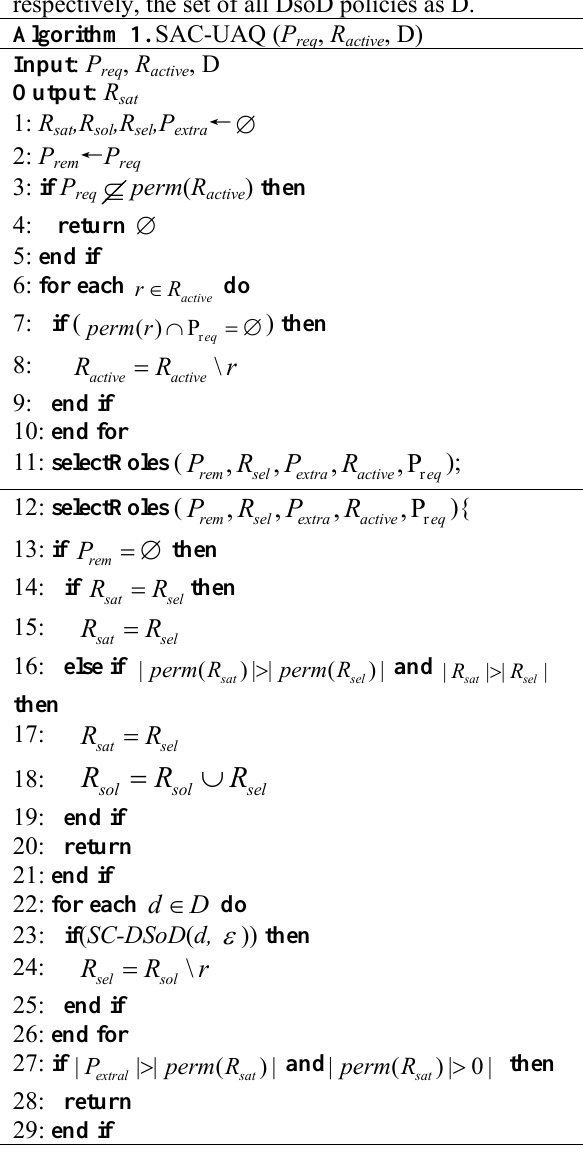
Algorithm 1. SAC-UAQ ( P